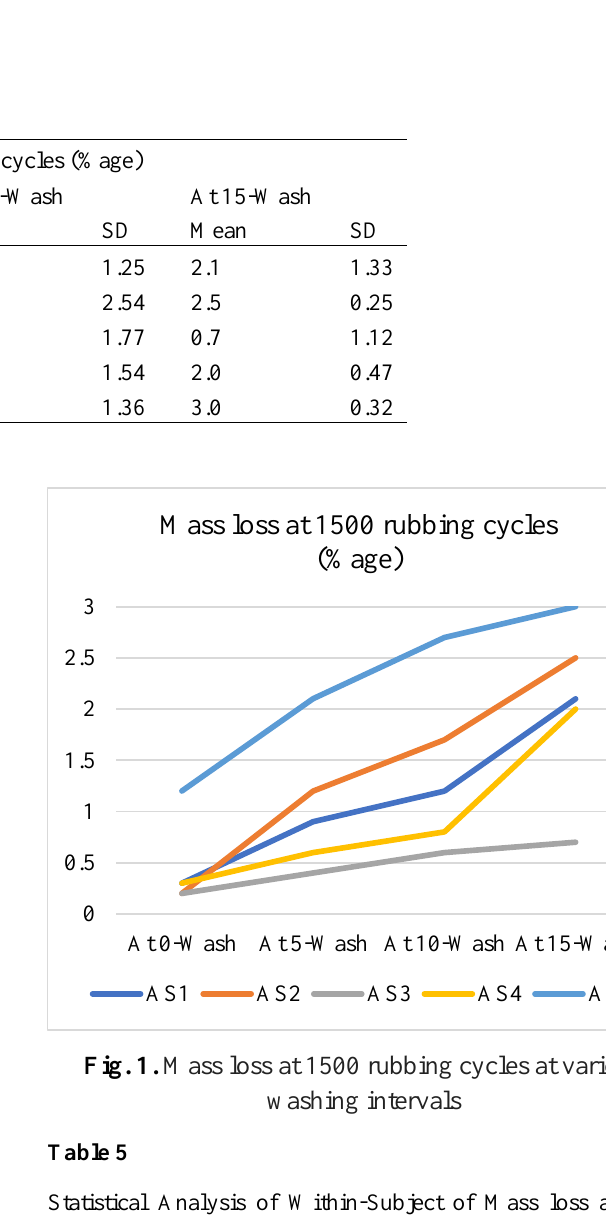
Statistical Analysis of Within-Subject of Mass loss at